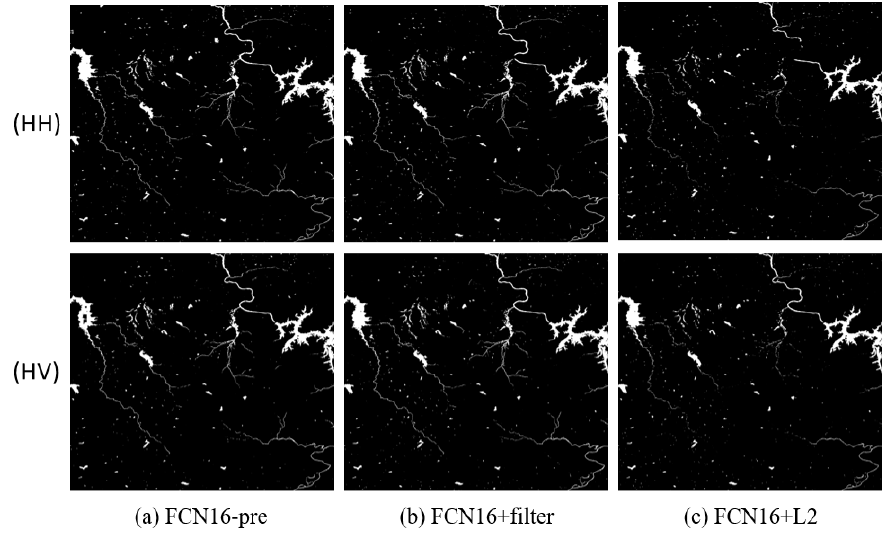
Figure 13. The results of FCN16 in three different conditions of Scene 2: ( a ) FCN16 without pre-process; ( b ) FCN16 with filtering after pre-process; and ( c ) FCN16 using L2 regular in loss